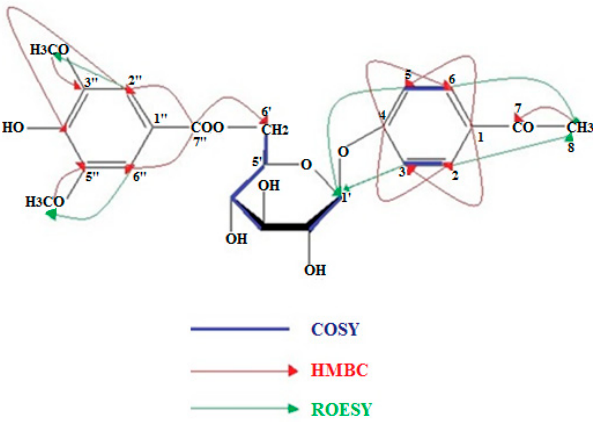
Figure 2. COSY, HMBC,and ROE signals of compund 11.